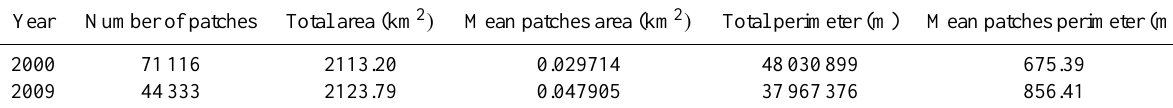
Table 1. Comparison of wetland landscapes of 2000 and 2009.